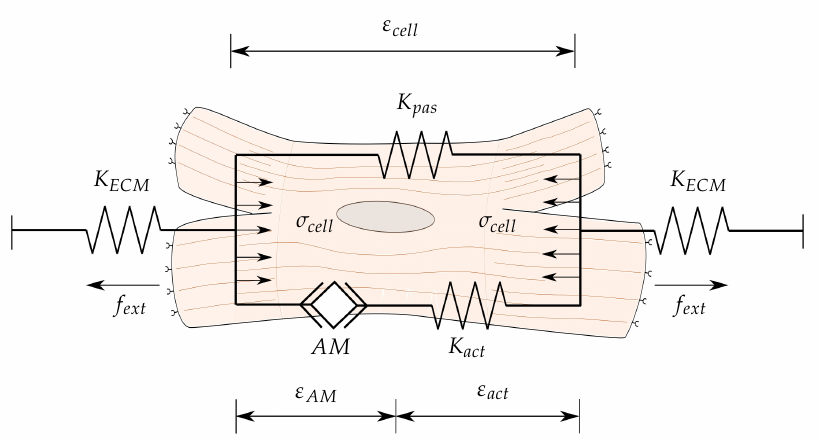
Figure 1. Mechanical model of the cell. The Actin-Myosin (AM) filaments generate cell internal contraction, ε AM , which is transmitted through the active, K act , and passive, K pas , elements, generating cell internal deformations, ε cell , and the resulting stresses, σ cell . Likewise, f ext corresponds to the extracellular matrix (ECM) stresses generated by the deformation of the ECM with a stiffness K ECM